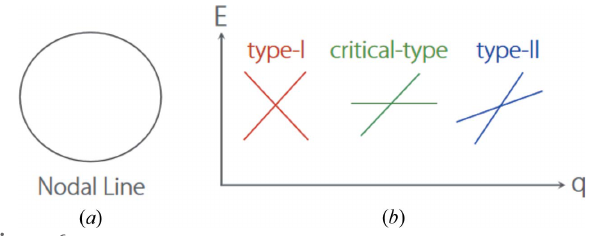
Figure 6 Schematic illustrations of ( a ) a nodal line and ( b ) type-I, critical-type and type-II band dispersions in the momentum–energy space.